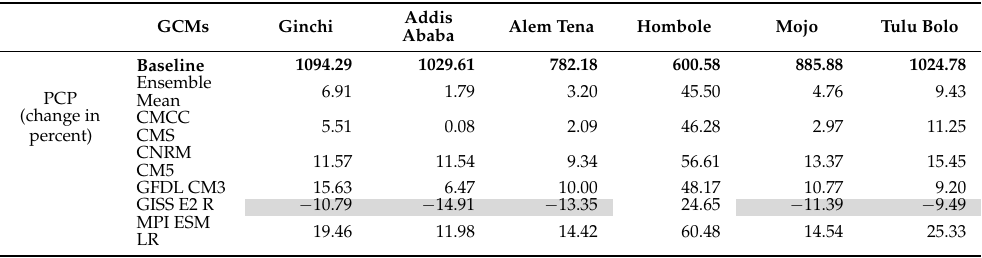
Table 8. Mean annual precipitation (mm) and change in percent for the different GCMs (the shaded cells are negative change compared with the baseline).